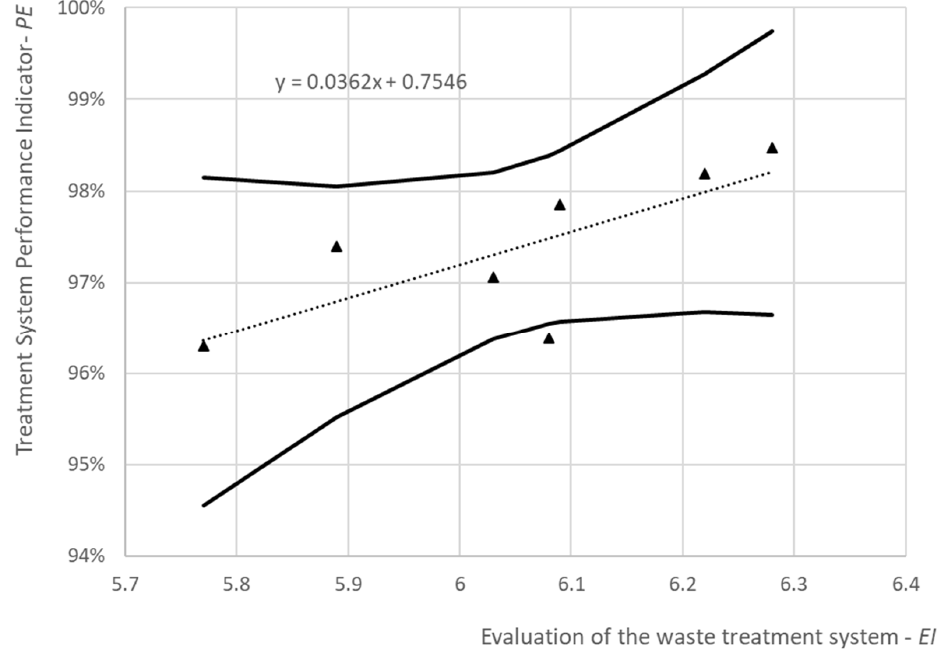
Figure 11. Regression curve describing the effect of grade on sorting performance.